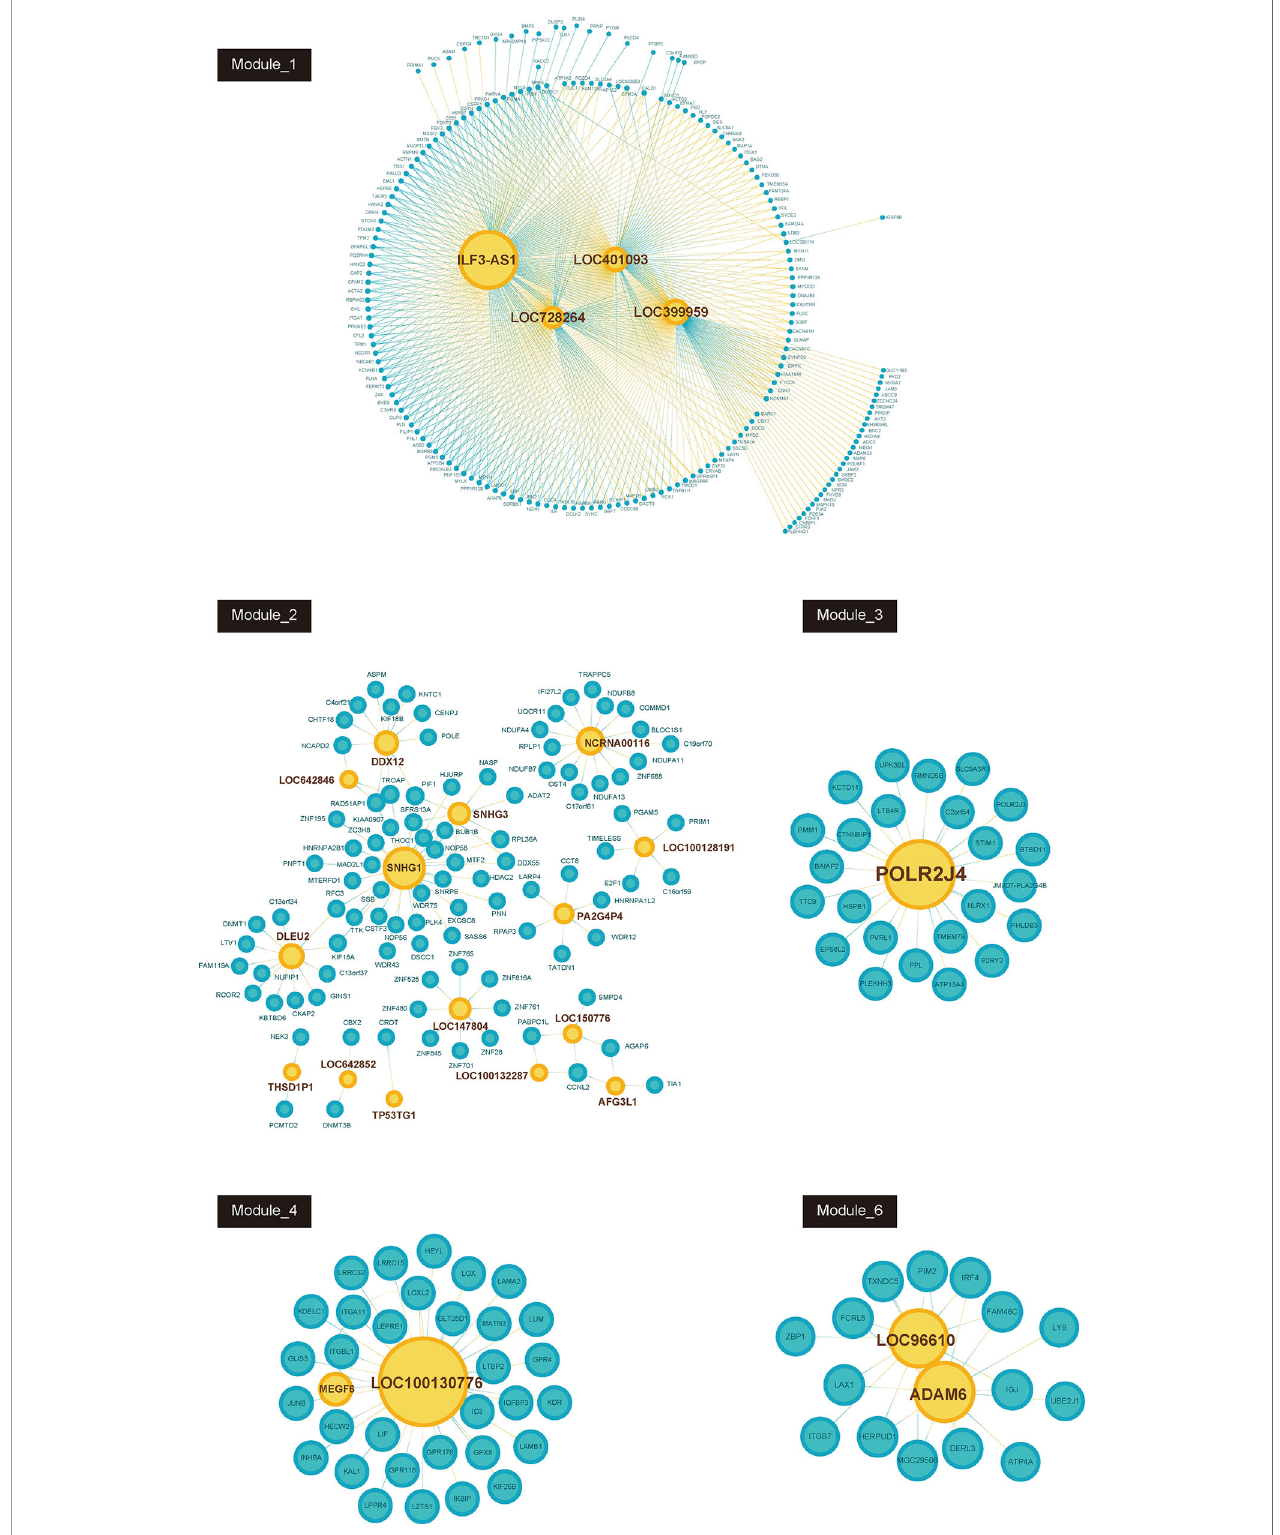
FIGURE 3 | Co-expression network between lncRNAs and mRNAs in each modules (Module_1, Module_2, Module_3, Module_4, Module_6). Blue node represents lncRNA; pink node represents mRNAs. The size of node depends on the connectivity degree of